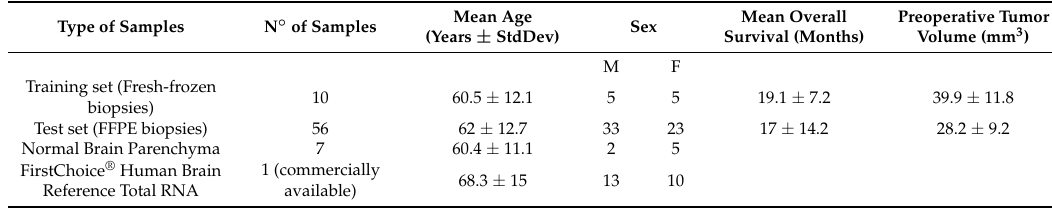
Table 1. Clinical data of GBM and control